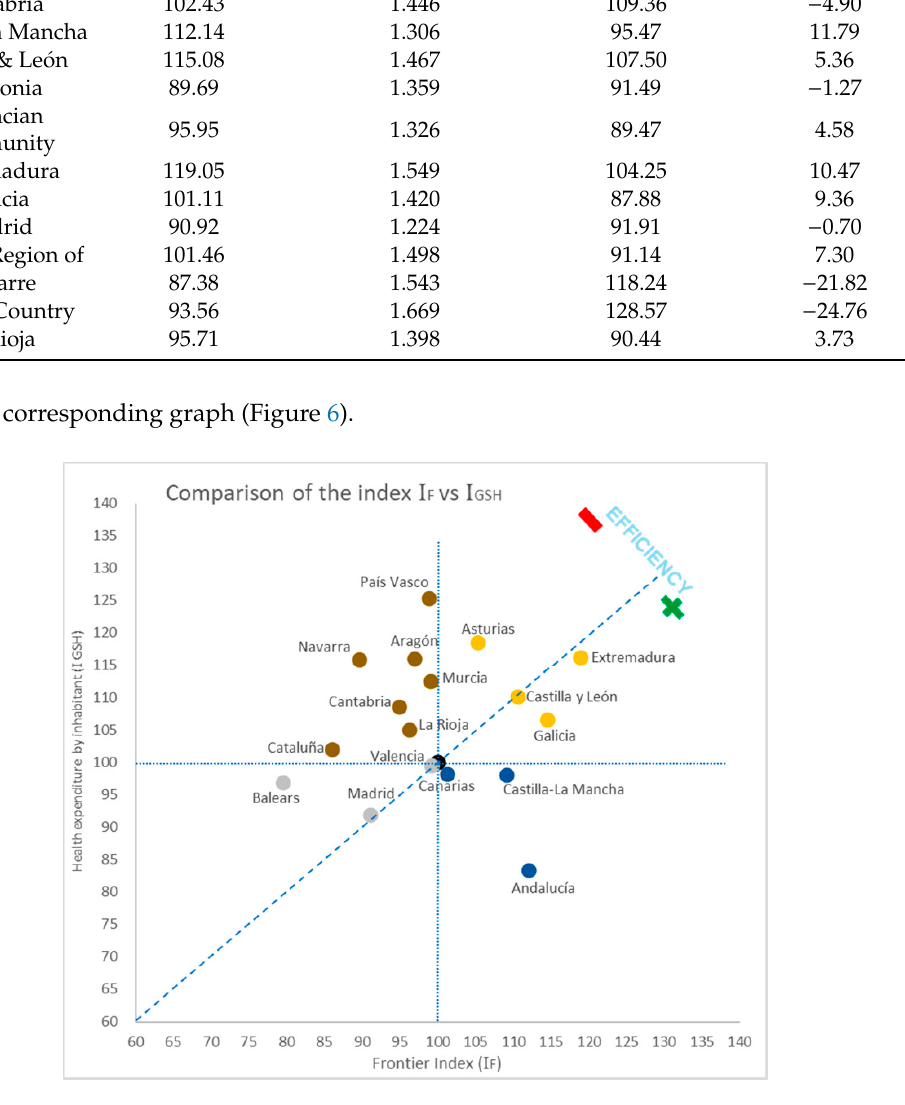
Figure 6. Comparison of the index IF vs. IGSH.